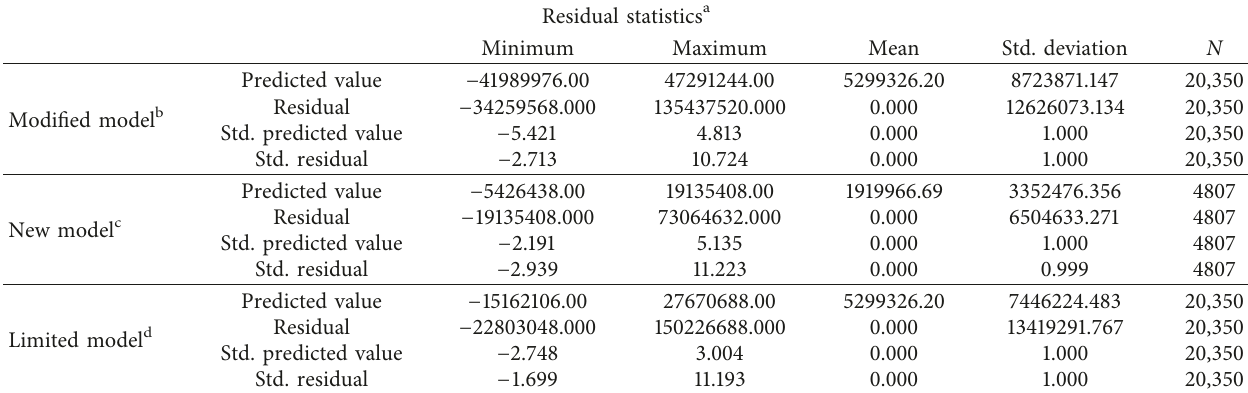
a Dependent variable: heating load of a DOE medium office building. b Predictors: (constant), visibility, diffuse radiation, atmospheric station pressure, wind speed, total sky cover, dew point temperatures, direct normal radiation, relative humidity, global horizontal radiation, and horizontal infrared radiation; c predictors: (constant), precipitable water, direct normal radiation, total sky cover, AOD, atmospheric station pressure, dew point temperatures, dry bulb temperatures, horizontal infrared radiation; d predictors: (constant), total sky cover, wind speed, dry bulb temperatures, global horizontal radiation, relative humidity, atmospheric station pressure, dew point